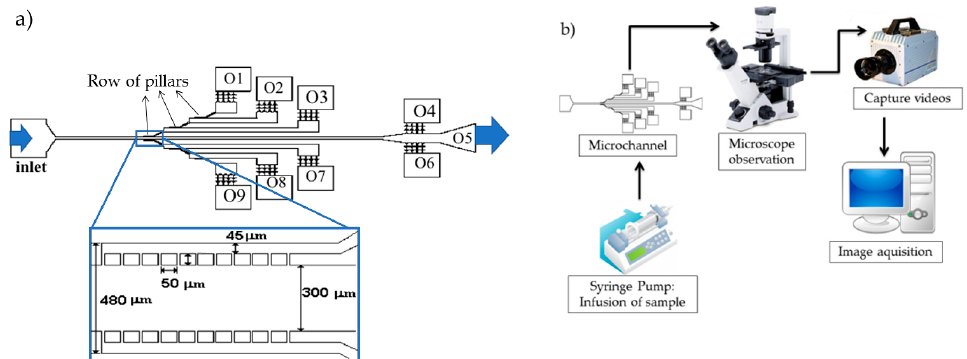
Figure 1. ( a ) Microchannel geometry with nine outlets (O1–O9). The arrows indicate the positioning of the rows of pillars in the microfluidic device. The left arrow indicates the region where the pillars have a 17 µm spacing between them, the central arrow indicates the region where the pillars have a 16 µm spacing between them, and the right arrow indicates the region where the pillars have a 14 µm spacing between them. The zoomed area beneath the microfluidic device represents two rows of pillars where each pillar has a 50 × 50 µm dimension and is separated from its neighbors by 17 µm; ( b ) Experimental setup comprising a high-speed camera, inverted microscope, and syringe pump system.